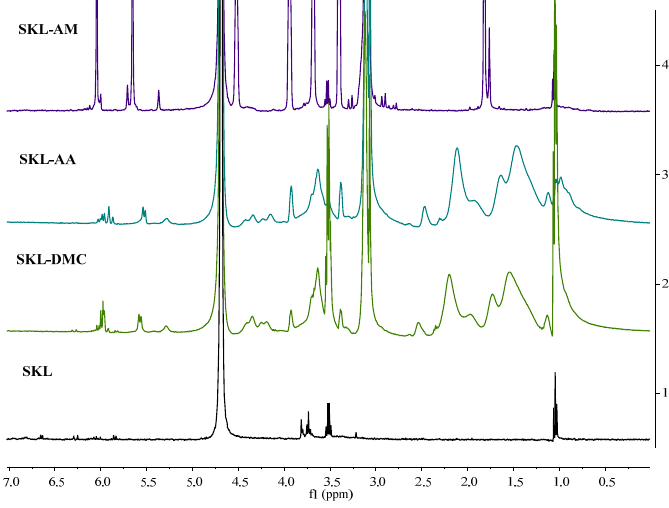
Figure 3. 1 H ‐ NMR spectra of SKL and SKL copolymers. Figure 3. 1 H-NMR spectra of SKL and SKL